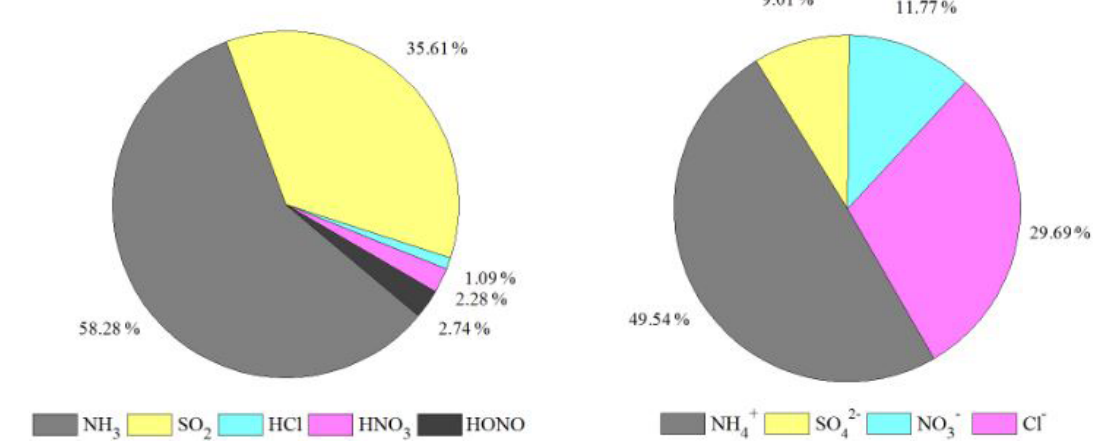
Figure 3. Share of major components of gases and particulate matter (PM 2 . 5 ) based on the mean concentrations during WiFEX (share according to µeqm − 3 ).